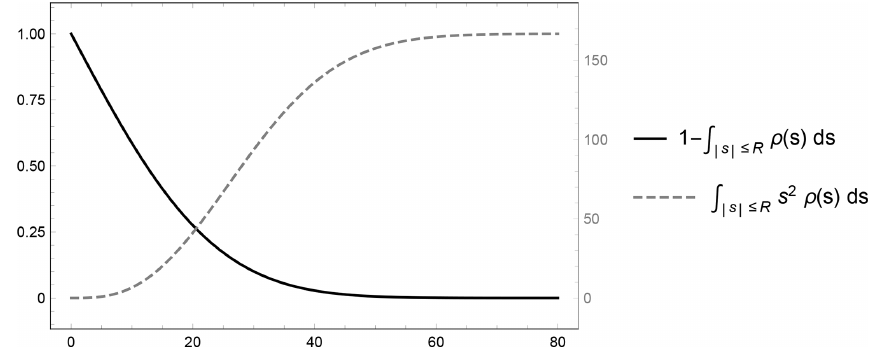
Figure C1. Growth and decay of the coefficients in the bounding terms of the radial velocity measurement error with increasing threshold distance, R . The WindCube V2 RWF (Eq. 6 with parameters in Table 1) is used for